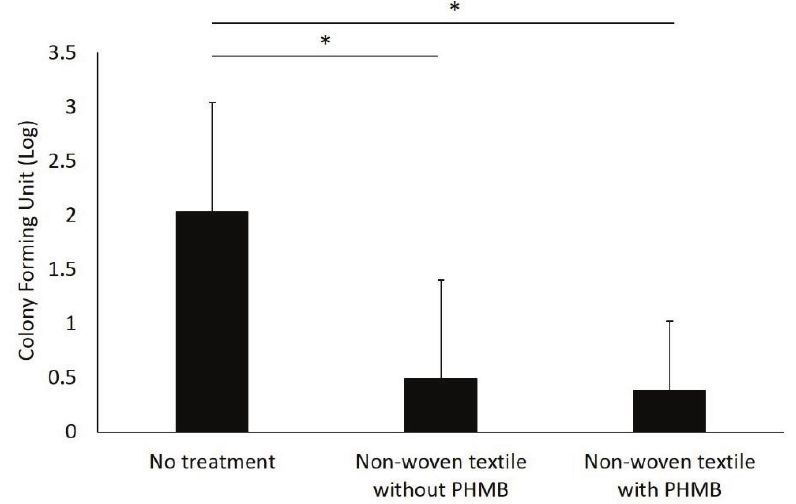
Figure 4. Antifungal effect of PHMB in healthy volunteers. Values indicate log-transformed CFUs. To calculate log CFUs for each feet, we added 0.5 for each raw value. Value in the soap washing group was zero and not shown in this graph. Error bars indicate standard deviation ( n = 4). * p < 0.001, multiple comparison by Bonferroni